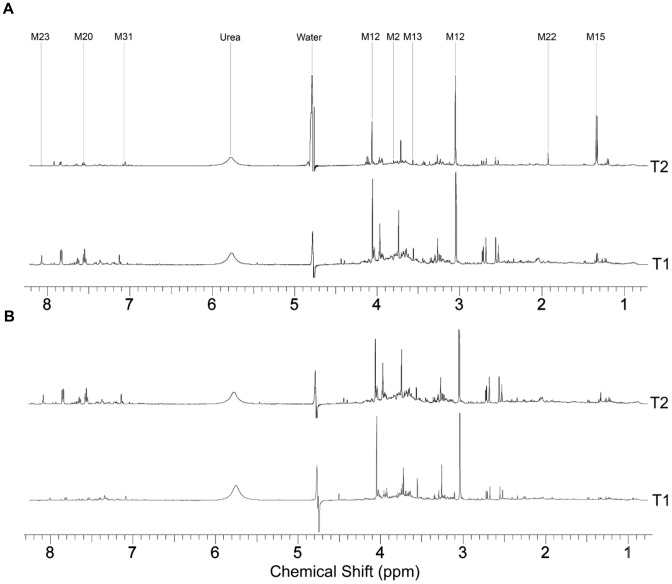

1H NMR spectra of control and athlete urine samples.
1H NMR spectra of a representative pre- (T1) and post-exercise (T2) urine sample from an athlete (A) and control (B) subject highlighting visible differences between the two spectra and the major resonances. Numbered biomolecules correspond to Table 3.